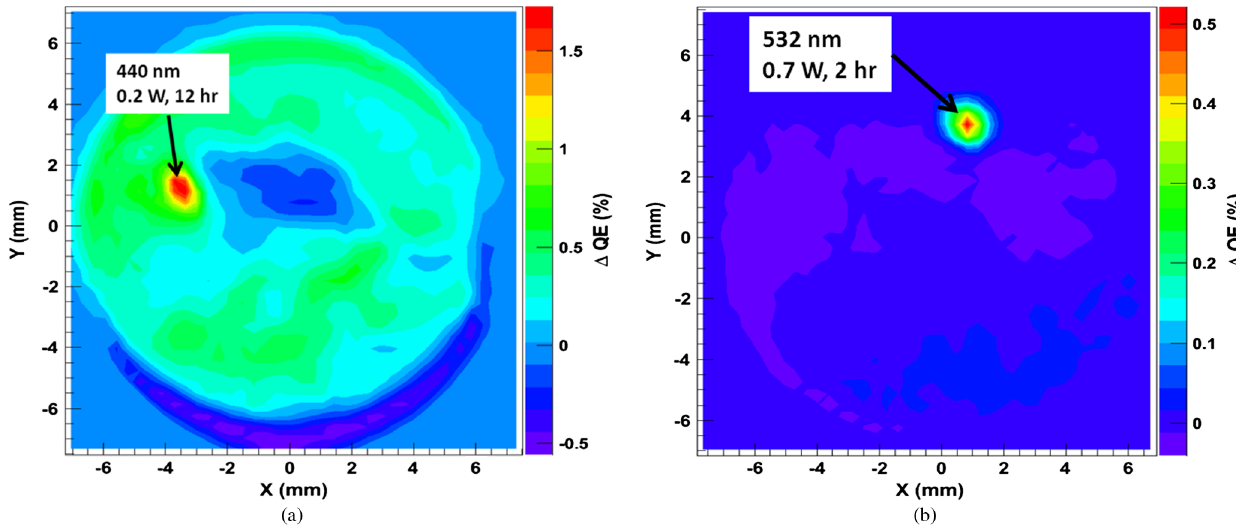
FIG. 11. QE difference scans of K 2 CsSb photocathode #1 using (a) 440 nm laser at 0.2 W for 12 hrs and (b) 532 nm laser at 0.7 W for 2 hrs. The photocathode was at ground potential, no beam was extracted while the laser was illuminating the photocathode. The QE increased due to the presence of the laser light, at both